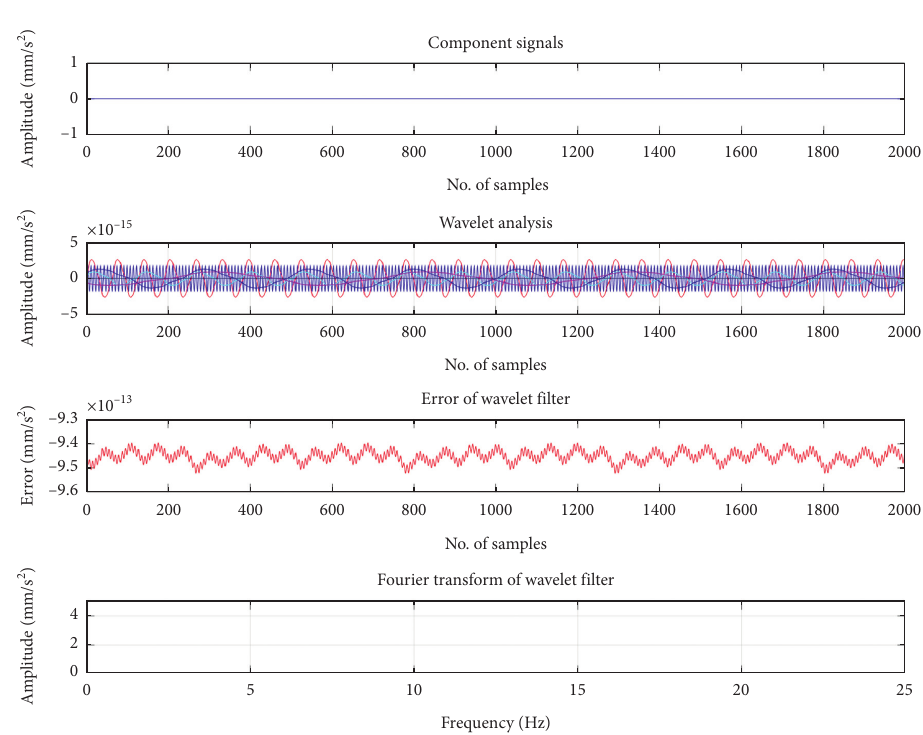
Figure 7: Amount of signal noise during data processing and use of measuring